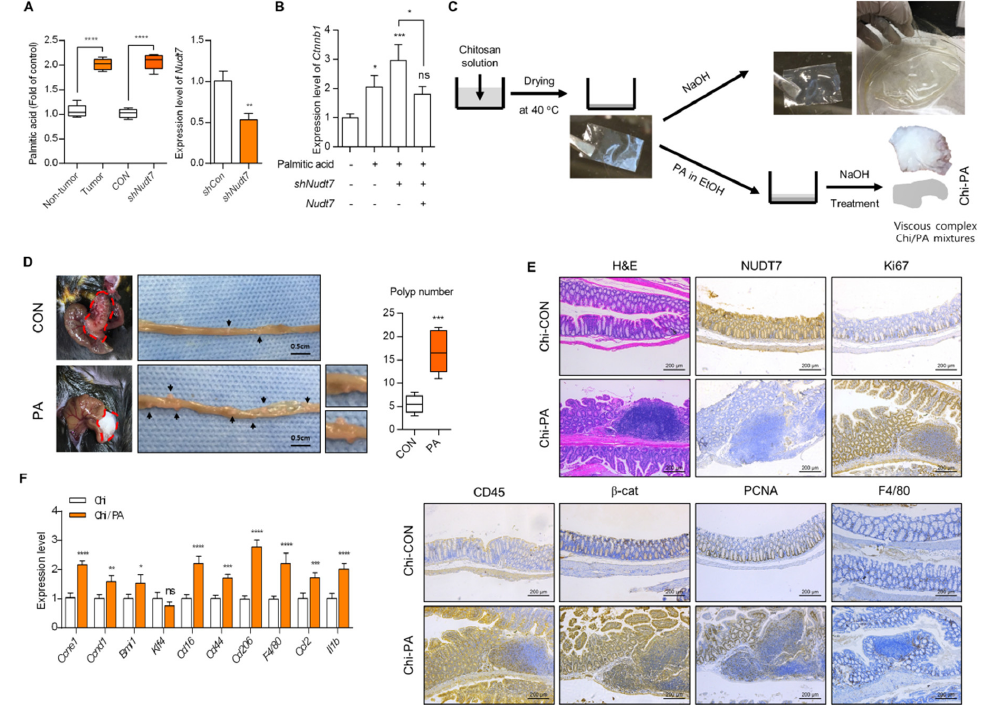
Figure 6. Accumulated palmitic acid is responsible for activation of β-catenin signaling. ( A ) Lipidomics was applied and the expression level of palmitic acid (PA) was analyzed in CRC tumors or shNudt7 introduced Kras WT CRC cells (left panel) ( n = 4). The efficiency of shNudt7 was confirmed using Kras WT CRC cells (right panel). ( B ) Kras WT Caco2 cells were introduced with Nudt7 or shNudt7 in the presence of PA and the expression level of β-catenin was analyzed by real-time PCR and represented as the fold change compared with the negative control (-palmitic acid/- shNudt7 /- Nudt7) . Results are representative of at least 3 independent experiments. Rn18s was used as an endogenous control. ( C ) Schematic diagram of generating Chi or Chi/PA film. ( D ) Chi or Chi/PA film was attached in the colon of Nudt7 +/+ mice for one week and polyp number was counted. Scale bars: 0.5 cm. ( E ) Immunohistochemistry with H&E, NUDT7, Ki67, CD45, β -catenin, PCNA, and F4 / 80 (n = 5) colon-attached Chi or Chi / PA film. Results are representative of at least 3 independent experiments and for every 100 cells in 3 di ff erent fields at 100 × magnification. Scale bars: 200 µ m. ( F ) Expression level of CRC-related genes in colon-attached Chi or Chi / PA film and represented as the fold change compared with colon-attached Chi film. Results are representative of at least 3 independent experiments. * p ≤ 0.05, ** p < 0.01, *** p < 0.01, **** p <